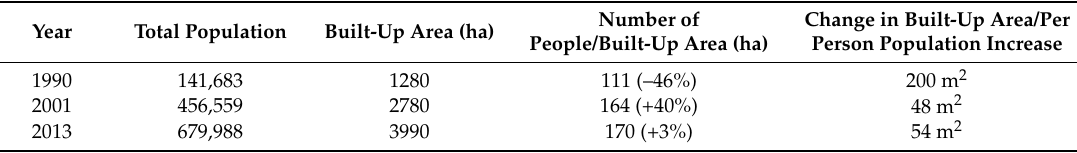
Table 8. Population growth and urban sprawl in Al-Khobar: